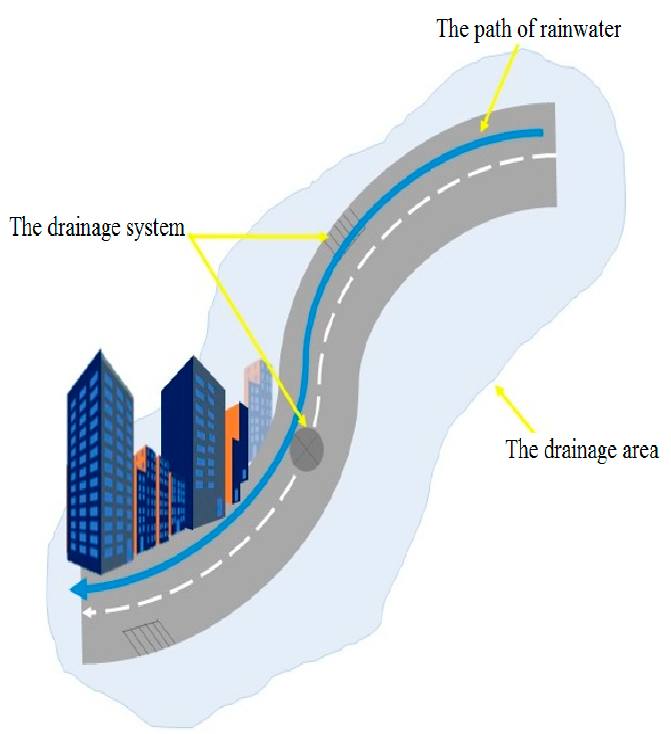
Figure 6. The rainfall and drainage system area.